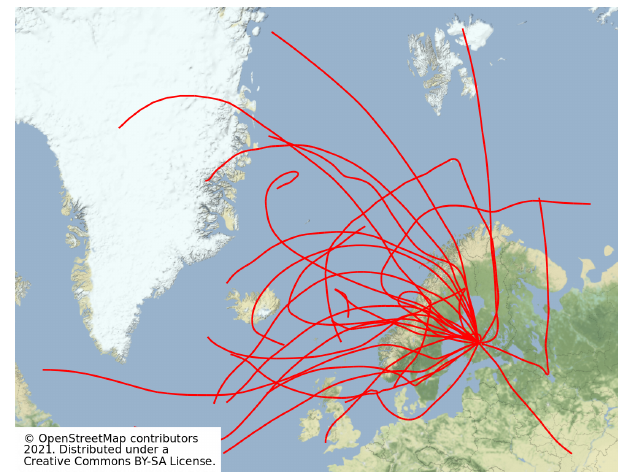
Figure 8. Air mass back trajectories arriving at altitudes over Hyytiälä where nucleation mode particle layers were located based on airborne data and the BAECC data. We calculated the air mass histories for 72h; however, in the figure some of the trajectories are truncated to fit the map. The trajectories were calculated based on two different conditions. First, based on the BAECC data analysis (Sect. 3.5) such that the air mass arrived at the top of the RL when the ML reached that altitude (see Table 1 for these altitudes and times). Second, based on the vertical profiles between 2011–2018 (Sect. 3.4) such that the back trajectories arrived at 2600m altitude at 10:00UTC on the days when the N 10–25 in 2000–3000m altitude range exceeded the 75th percentile N 10–25 value.